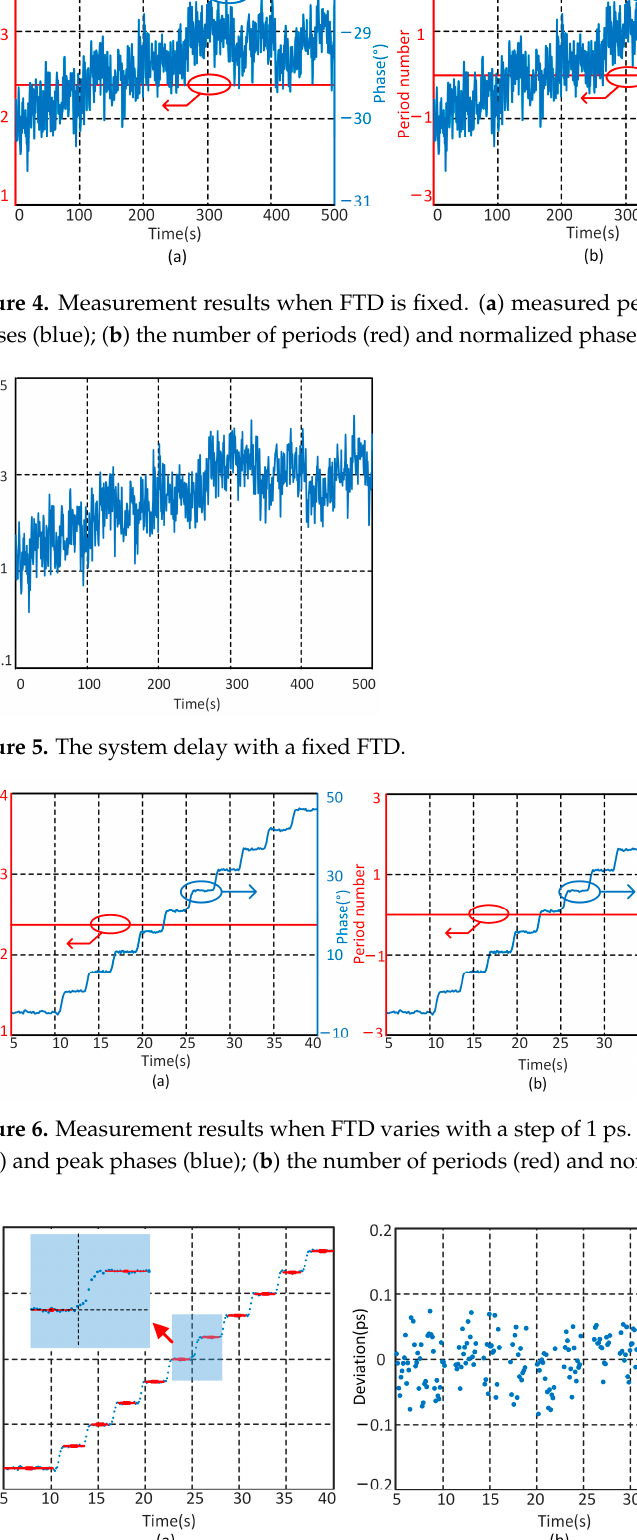
Figure 6. Measurement results when FTD varies with a step of 1 ps. ( a ) measured peak frequencies (red) and peak phases (blue); ( b ) the number of periods (red) and normalized phases (blue). Figure 7. ( a ) The measured FTDs of the variable optical delay line; ( b ) the delay deviations of the measured